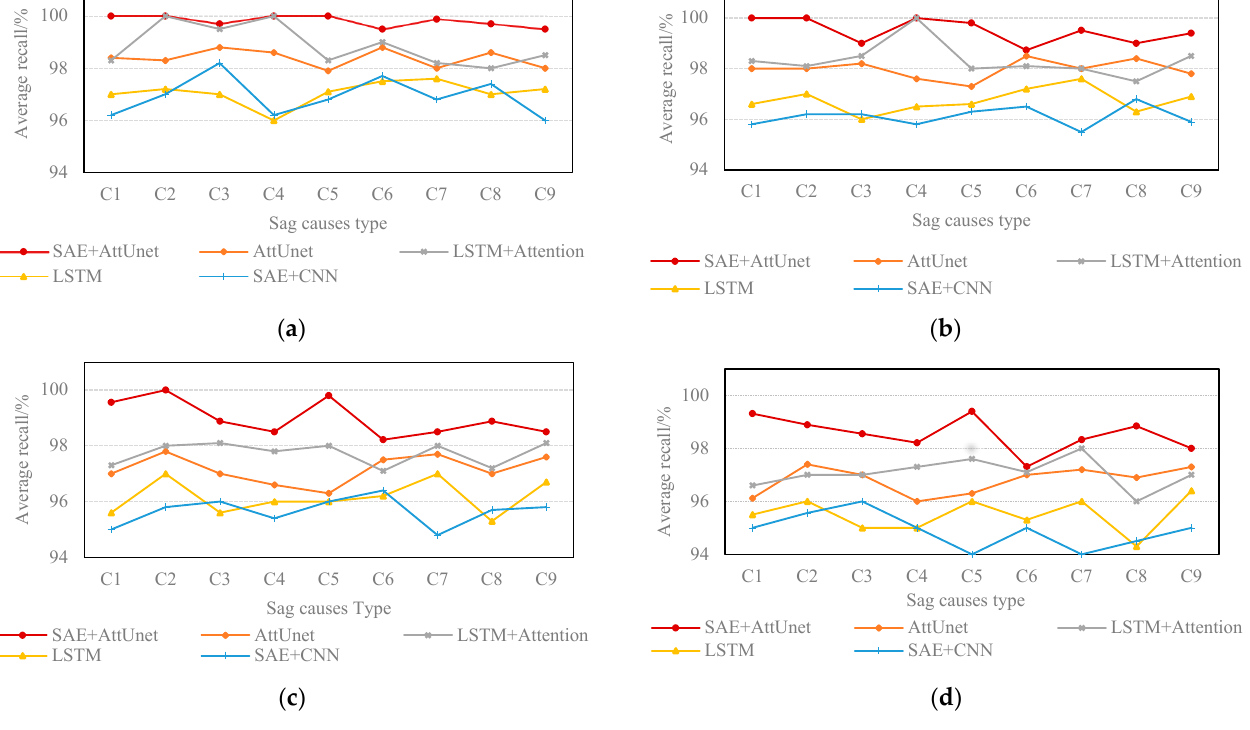
Figure 10. Comparison of model average recall under different noises. ( a ) Comparison of recognition accuracy at 50 dB; ( b ) comparison of recognition accuracy at 40 dB; ( c ) comparison of recognition accuracy at 30 dB; ( d ) comparison of recognition accuracy at 20 dB.